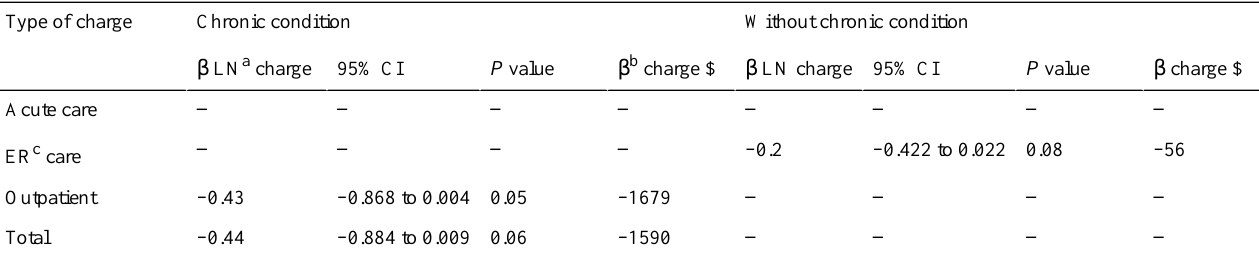
Table 4. Results of the difference-in-difference charge analysis for with and without chronic condition cohorts showing only the difference-in-difference statistic. The regression included the following variables: age, sex, HCC score, time, case, and time*case (which represents the difference-in-difference statistic after adjusting for the other variables). Where P <.10 for the natural log of the charge categories, 95% confidence intervals (CIs), and the P value and coefficient ( β ) for non–log-transformed charges are provided; if P ≥ .10, cells are left blank. Neither the with nor the without chronic condition cohort had difference-in-difference statistics that were P <.10 for acute